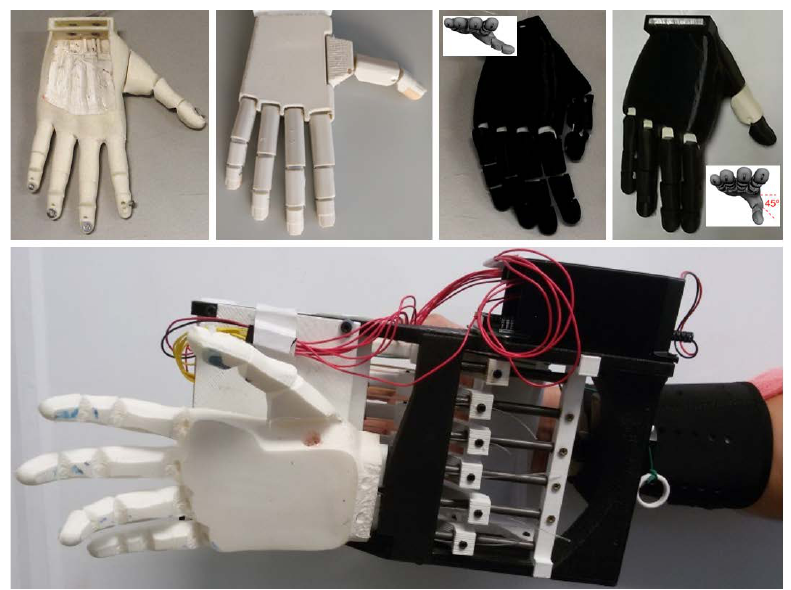
Figure 4. Affordable prosthetic hands, from left to right: Dextrus, IMMA, and Limbitless hands. The two versions of the Limbitless are depicted. Below is Able-Bodied Adaptor (ABA). The same 0.8 mm nylon thread (ultimate tensile stress of 220.5 N) was used as a